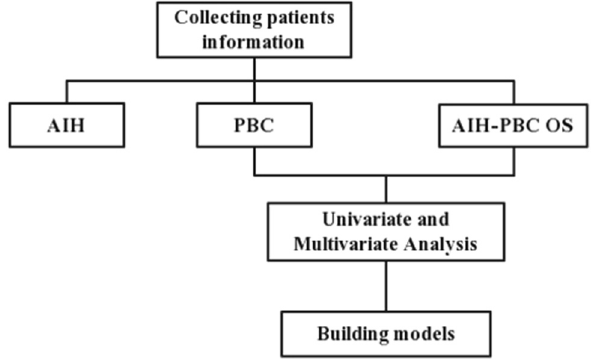
Figure 1: Brief scheme of the study design.